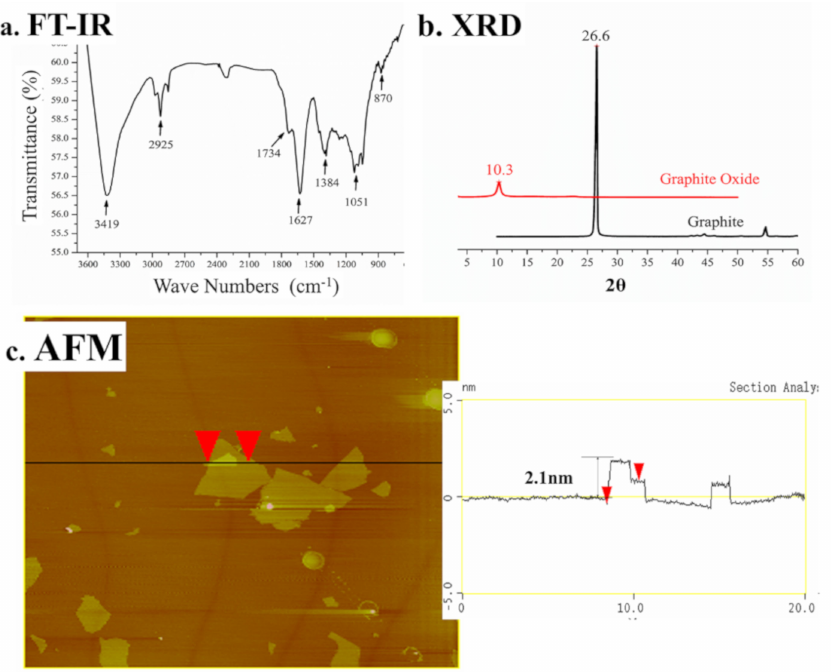
Figure 3. Characterization of GO: ( a ) FT-IR, ( b ) XRD, and ( c ) AFM tapping mode image and height